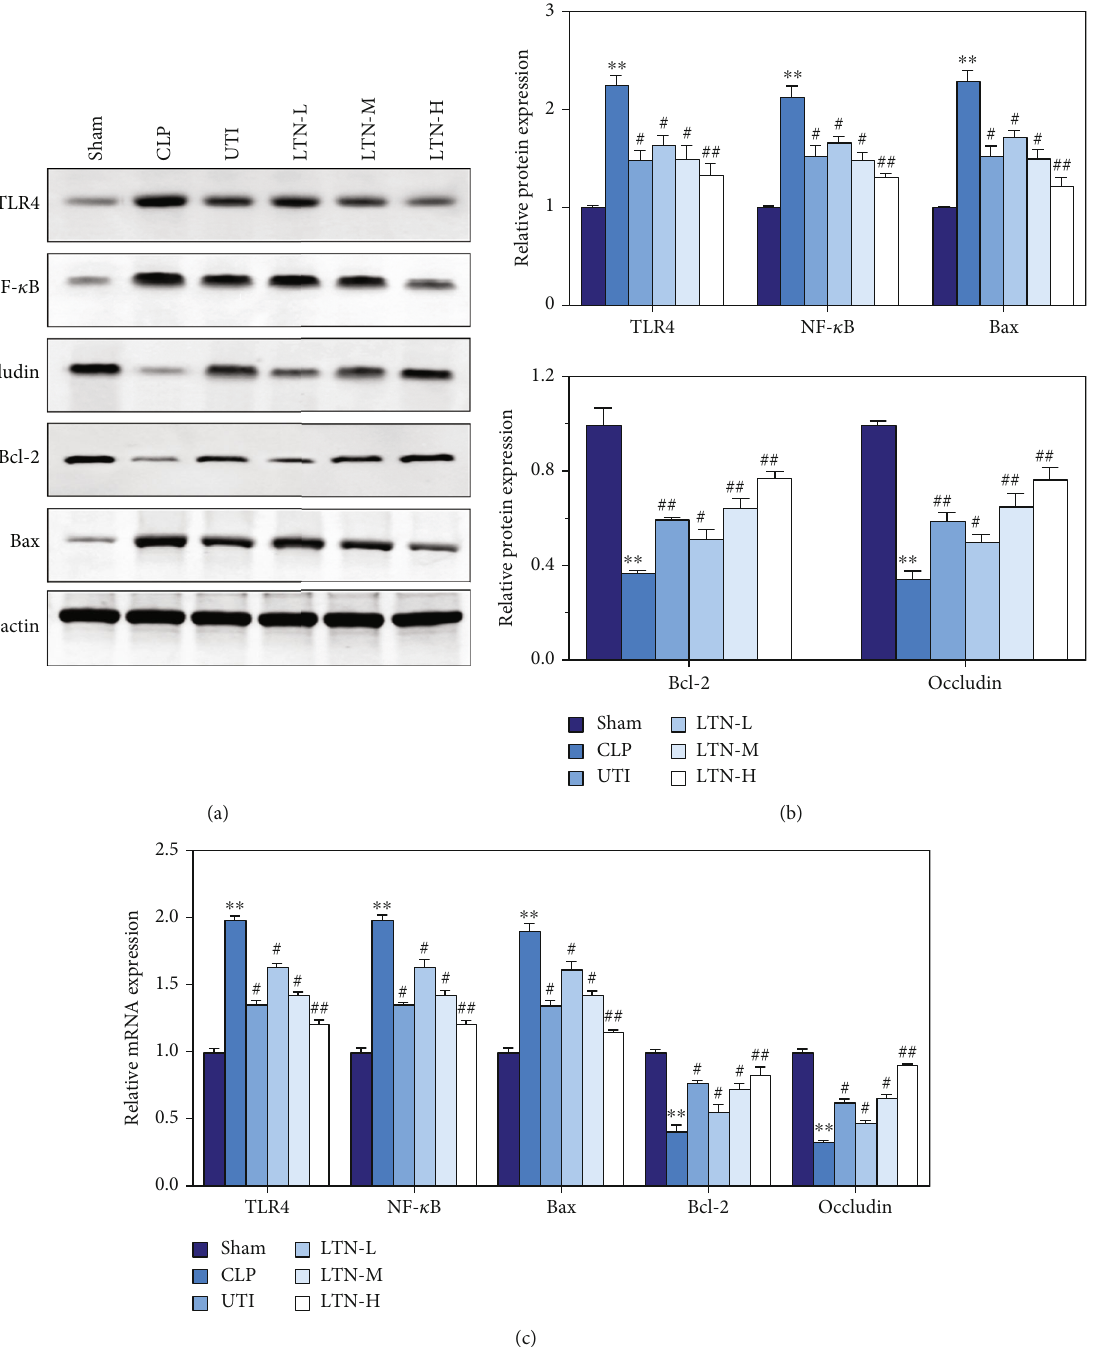
Figure 6: Lentinan downregulates the NF- κ B signaling pathway and thus inhibits apoptosis of intestinal epithelial cells. (a) Western blot was used to detect the protein expression of TLR4, NF- κ B, Bcl-2, occludin, and Bax in the small intestine tissue of each group. (b) Quanti fi cations of western blots. (c) RT-qPCR was adopted for detecting the mRNA expression of TLR4, NF- κ B, Bcl-2, occludin,